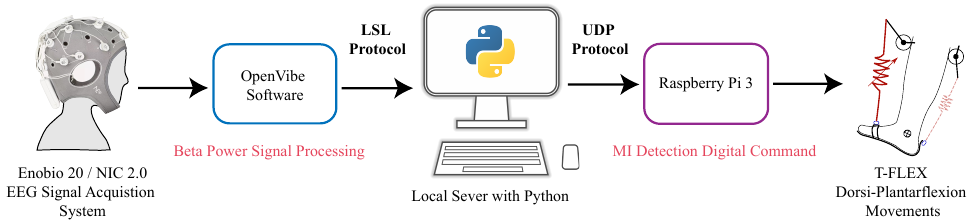
Figure 2. Communication protocols diagram for BCI—T-FLEX integration through a Local Server in